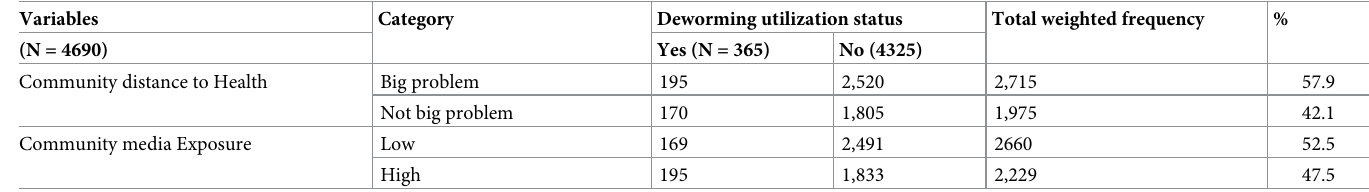
model (model III) containing both the individual and community level variables was consid- ered as the best fit model because it has the lowest deviance and AIC value (deviance = 2308, AIC = 2338.237, p-value = 0.0001). The presence of heterogeneity between clusters was also explained by the Median Odds Ratio (MOR). In the full model, the MOR was 2.5, which implies that the odds of utilization of deworming medications was 2.5 among mothers who came from a community with high to low proportion of deworming utilization status. The proportional change in variance (PCV) in the final model also indicates that 2.4% of the varia- tion in the utilization of deworming medication among pregnant mothers observed was explained by both community and individual-level variables. in the bi-variable multilevel binary logistic regression model were fitted into the final multivar- iable multilevel binary logistic regression model. In this regard, variables like religion, marital status, working status, ANC visit level, IFA intake status, decision maker on women’s health care needs, household media exposure status, community poverty level, community education level, and distance to the health facility level were computed in the full model (model III). Finally, working status, ANC visit level, IFA intake status, and community poverty level were identified as significant predictors of utilization of deworming among pregnant mothers. In comparison to their counterparts, pregnant women who took IFA tablets were 3.42